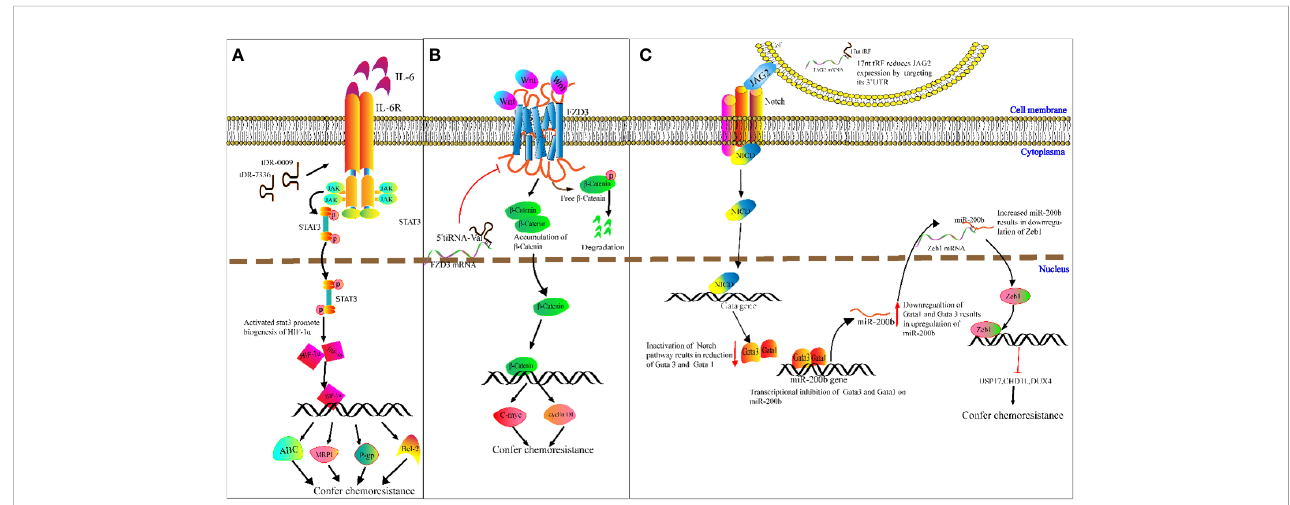
FIGURE 5 Molecular mechanism underlying tRNA-derived fragment (tRFs) regulation of carcinogenesis and chemoresistance. (A) DR-0009 and tDR-7336 activate the JAK/STAT3 pathway. Activated STAT3 promotes the biogenesis of HIF-1 a . HIF-1 a upregulates the expression of Bcl-2, ABC transporters, P-gp and MRP1. (B) 5 ′ tiRNA Val suppresses FZD3/Wnt/ b -Catenin signaling. Inhibition of Wnt signals results in the degradation of free b -Catenin followed by downregulation of c-Myc and cyclin D1. (C) The 17nt-tRF/miR-1280 suppresses Notch/JAG2 transmembrane signal transduction by downregulating JAG2. This then leads to transcriptional repression of Gata1 and Gata3 and upregulation of miR-200b. miR-200b downregulates ZEB1 by targeting its 3 ′ - UTR, followed by reduced expression of USP17, CHD1L and